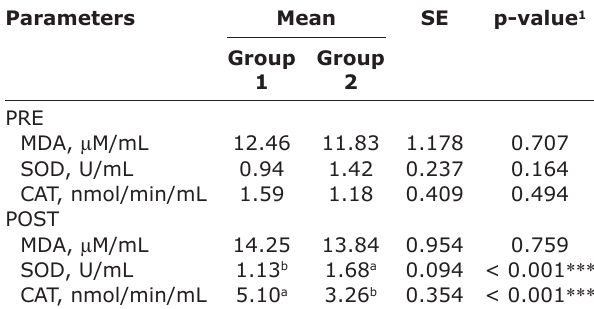
Table-3: Comparing malondialdehyde, catalase, and superoxide dismutase levels in blood samples of replacement gilts.